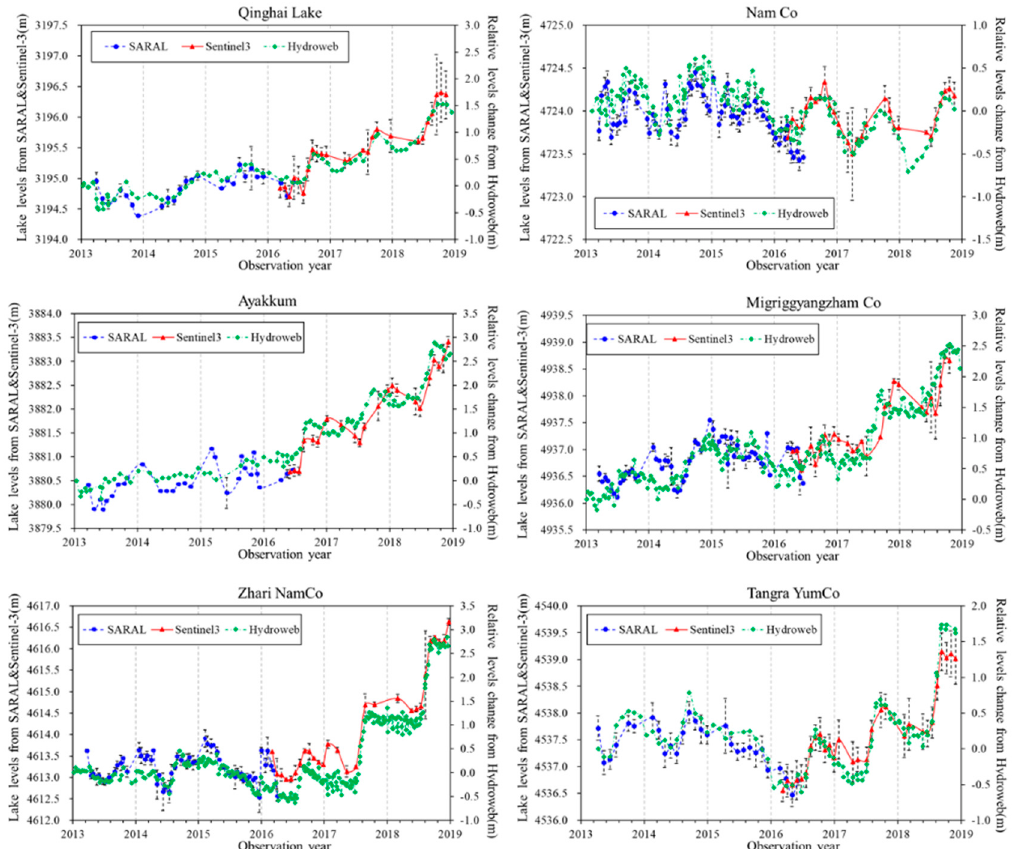
Figure 5. Comparison of lake level changes based on the Hydroweb/DAHITI and SARAL/Sentinel-3 altimetry data (relative levels changes refer to lake levels relative to the beginning of the time series).